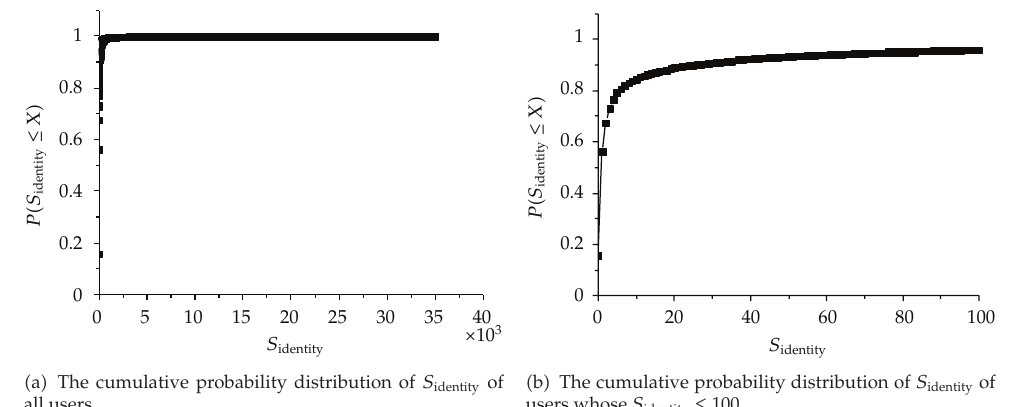
Figure 4: The cumulative probability distribution of S identity